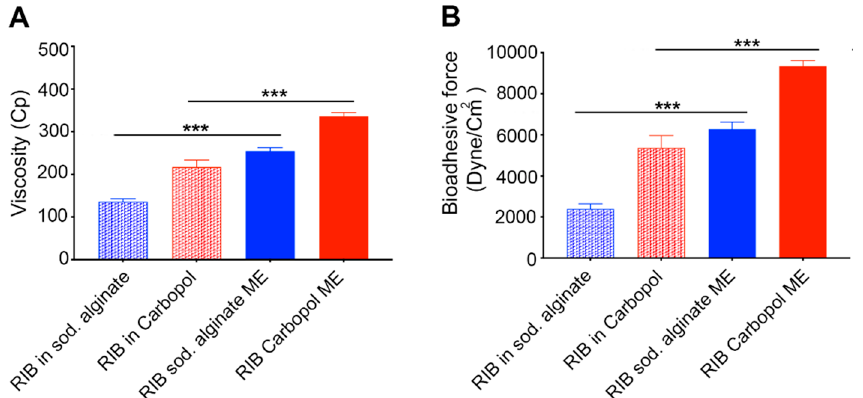
Figure 2. ( A , B ). Viscosity and bioadhesive force values of ribavirin-loaded Carbopol 981 and sodium alginate MEs and polymeric solutions, respectively. ME formulations possess higher viscosity and bioadhesive force than the polymeric solution formulation, regardless of the type of polymer, and Carbopol 981 formulations have higher viscosities and bioadhesive forces than those of sodium alginate. N = 3, *** = p < 0.001.